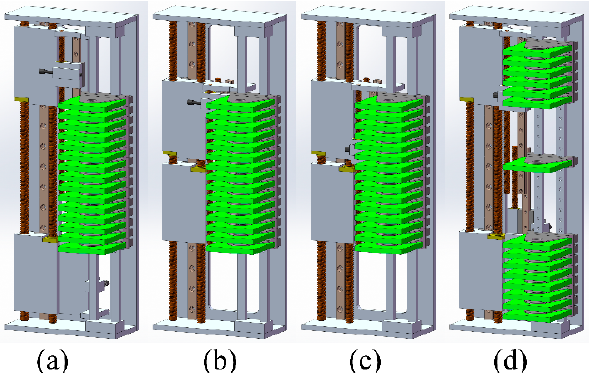
Figure 8. Shedding process in the shedding mechanism. ( a ) The initial state; ( b ) sliding tables move to the middle; ( c ) locking devices move and lock; ( d ) sliding tables move to both sides to form the shed.